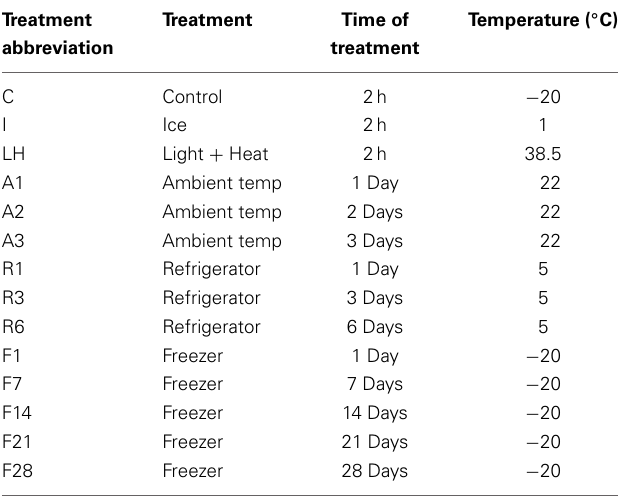
Table 1 | List of treatments for sample handling and